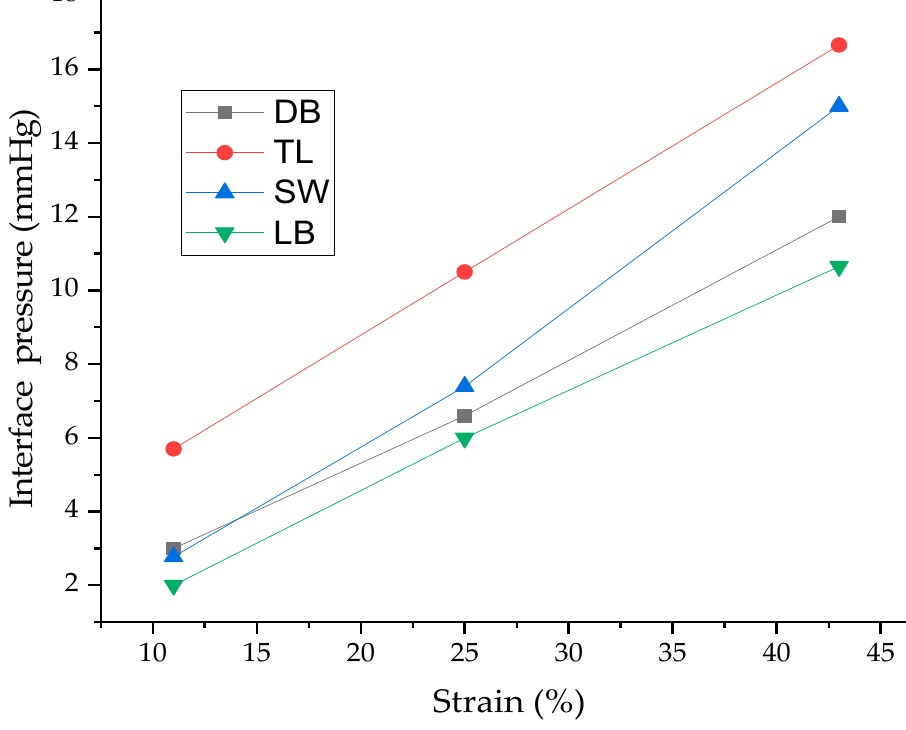
Figure 10. Interface pressure applied by the different samples at determined strain values of 10%, 20% and 30%.